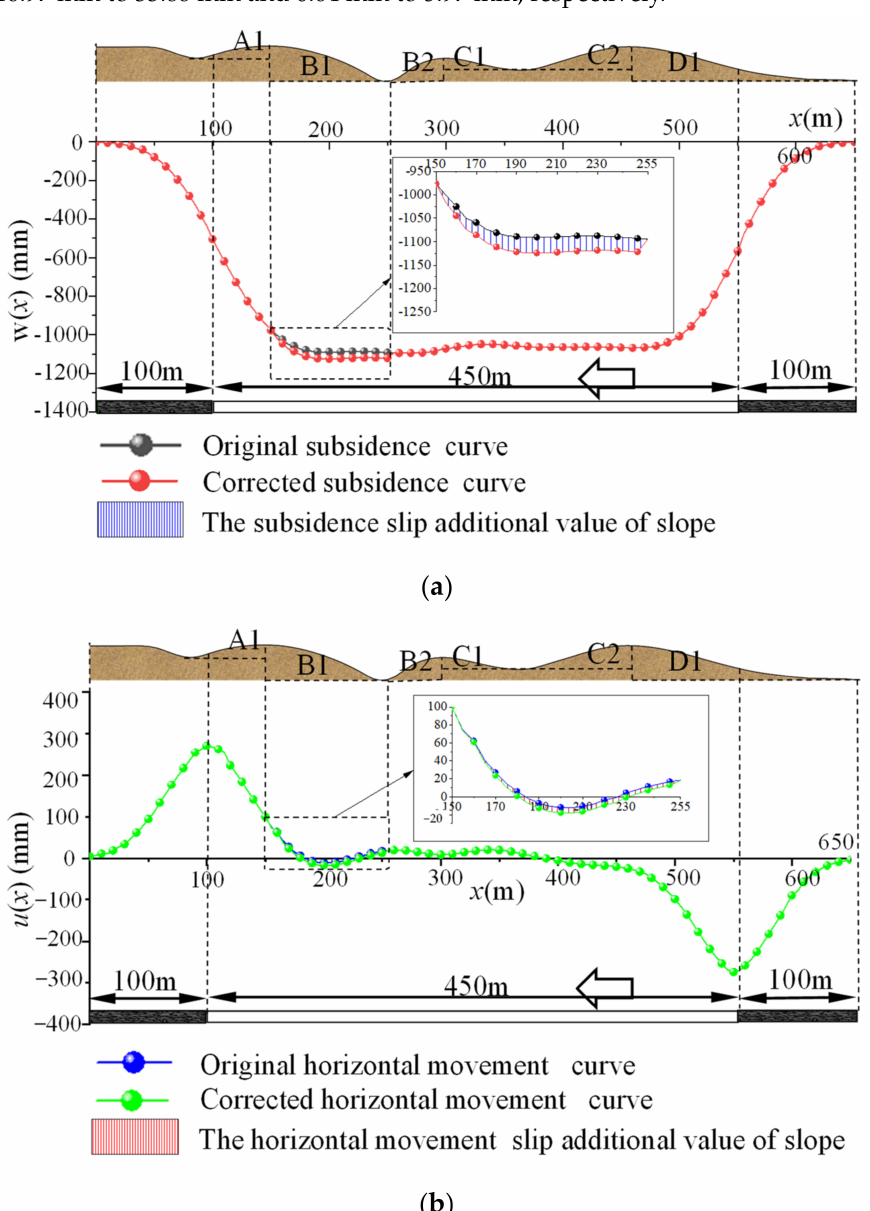
Figure 10. Surface movement prediction curve in dongas: ( a ) sinking curve; and ( b ) horizontal displacement